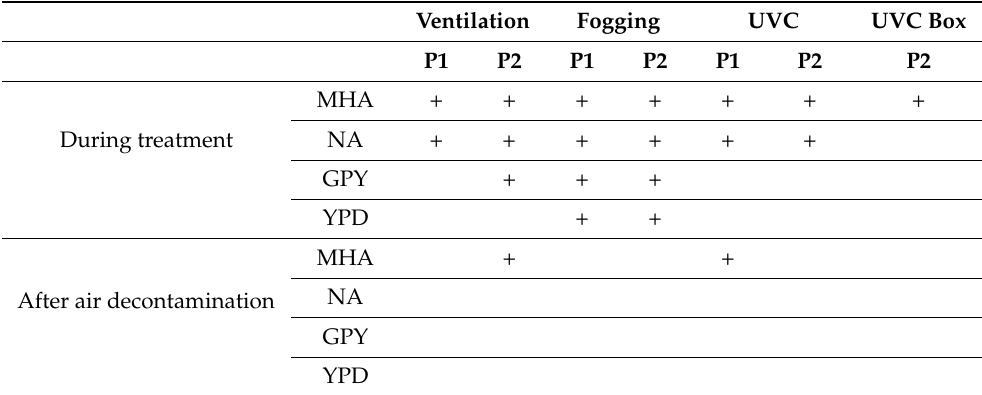
Table 2. Culture media that showed bacterial growth.